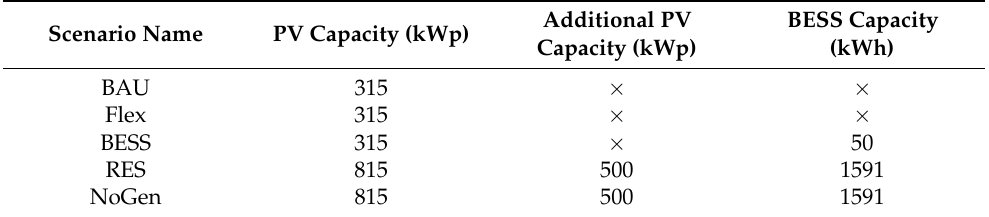
Table 7. PV and BESS optimal capacity results with higher diesel